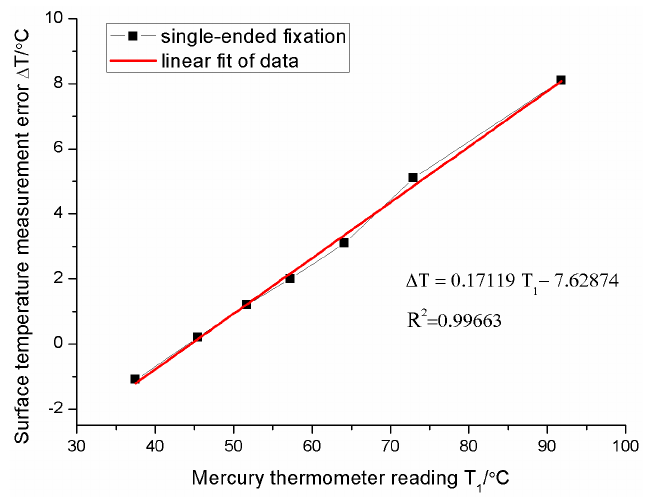
Figure 10. Surface temperature measurement errors of the sensor with the single-ended fixation.